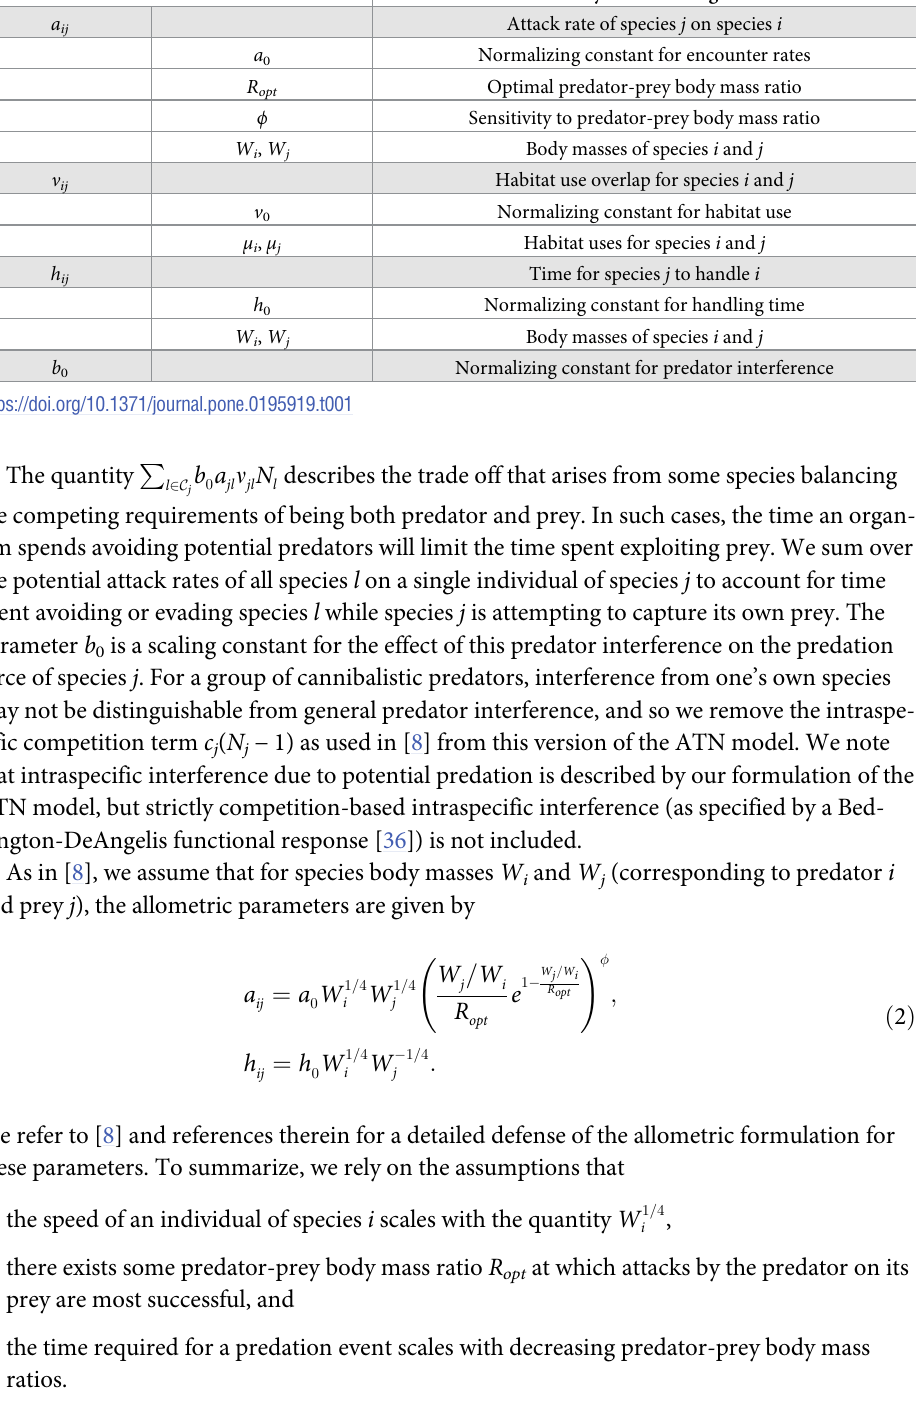
Table 1. Definitions of model parameters. Left-aligned parameters (in shaded cells) are defined in terms of the corre- sponding right-aligned parameters (in unshaded cells). See (2) and (3) for details.